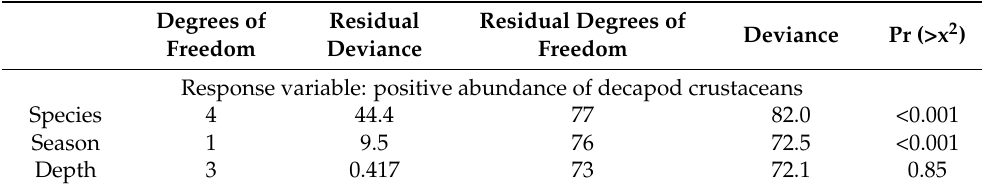
Table 2. Deviance analysis of predictor variables to model the positive abundance of decapod crus-